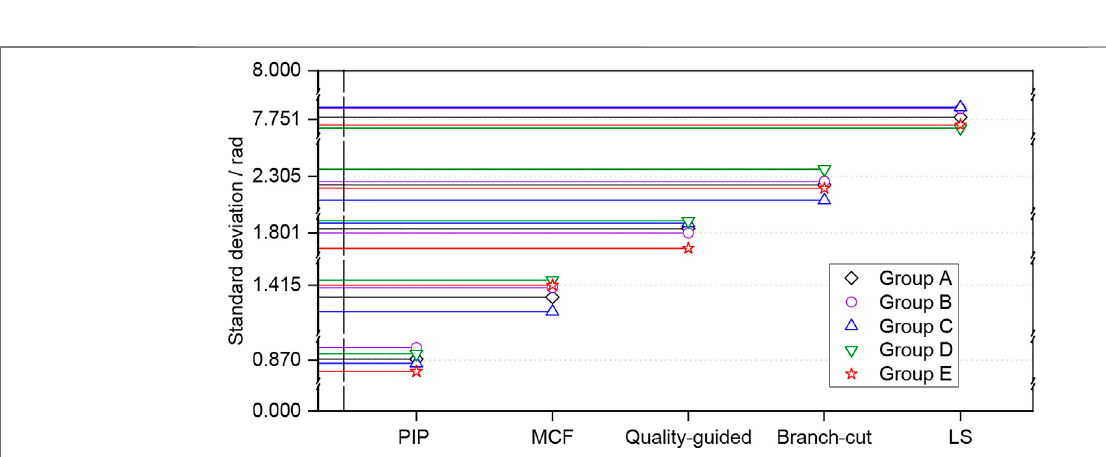
Frontiers in Environmental Science |